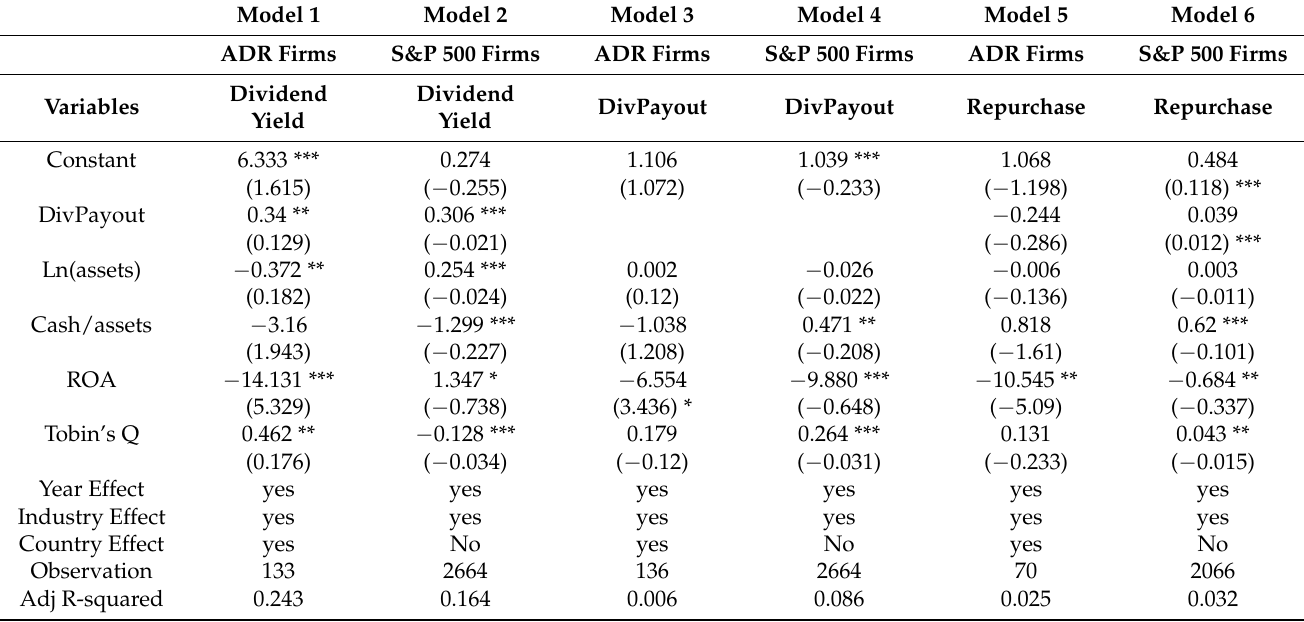
Table 3. Regression analysis of the dividend policy on firm